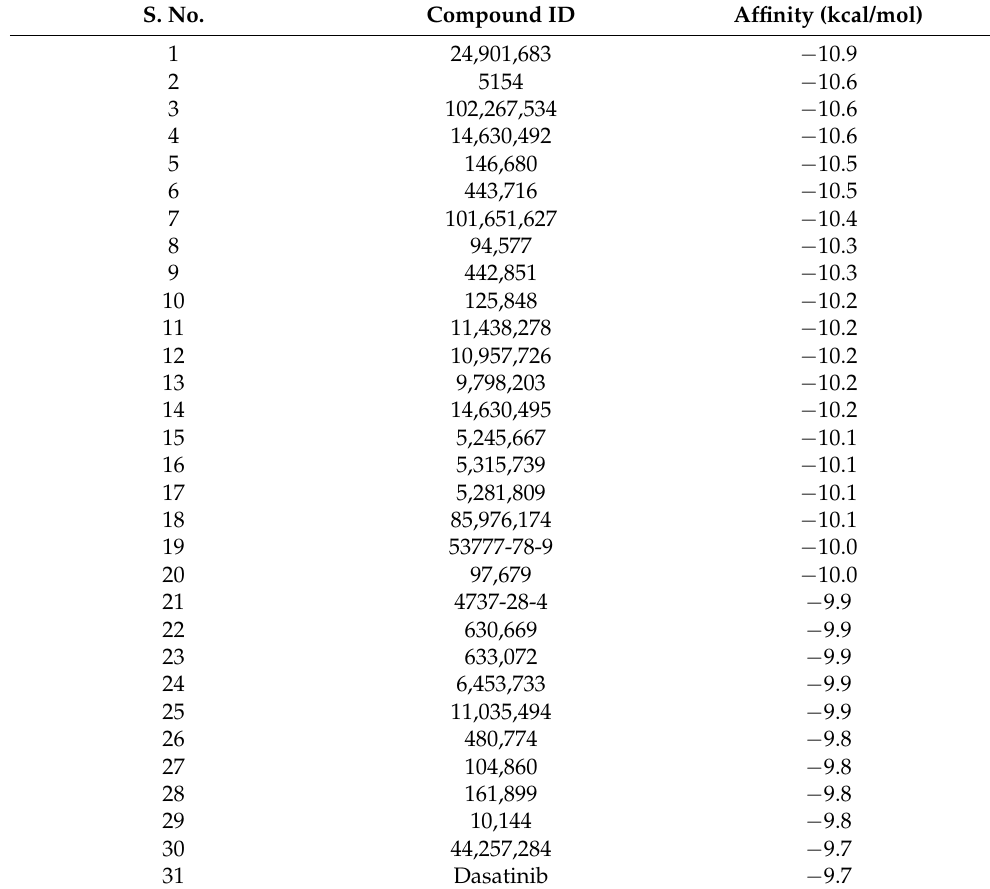
Table 1. Binding affinity of the selected top 30 hits against YES1.